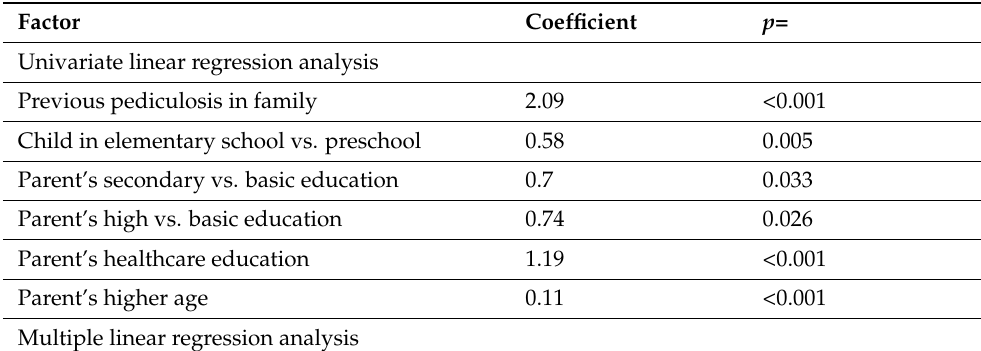
Table 5. Factors affecting the score of the correct answers to statements about pediculosis (univariate and multiple linear regression